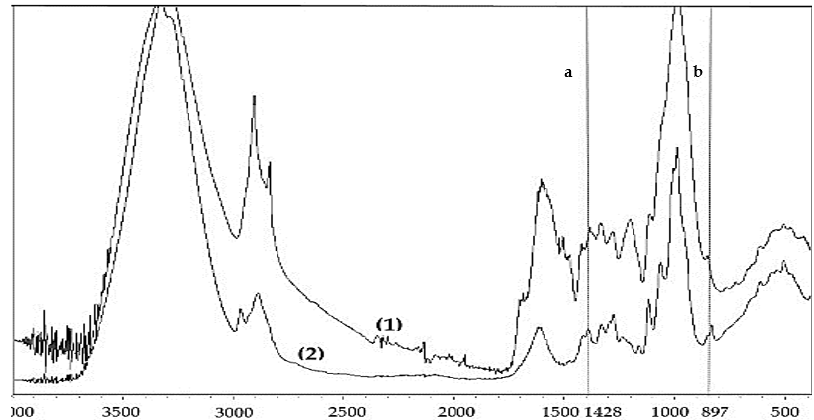
Figure 5. FTIR spectra of (1) untreated oil palm empty fruit bunches (OPEFB) and (2) glucan-rich fraction from the best organosolv pretreatment condition (0.07% H 2 SO 4 , 210 °C, 90 min, and solid-to-liquid ratio of 1:10). Bar (a) shows the absorbance at 1428 cm − 1 whereas bar (b) shows the absorbance at 897 cm − 1 .